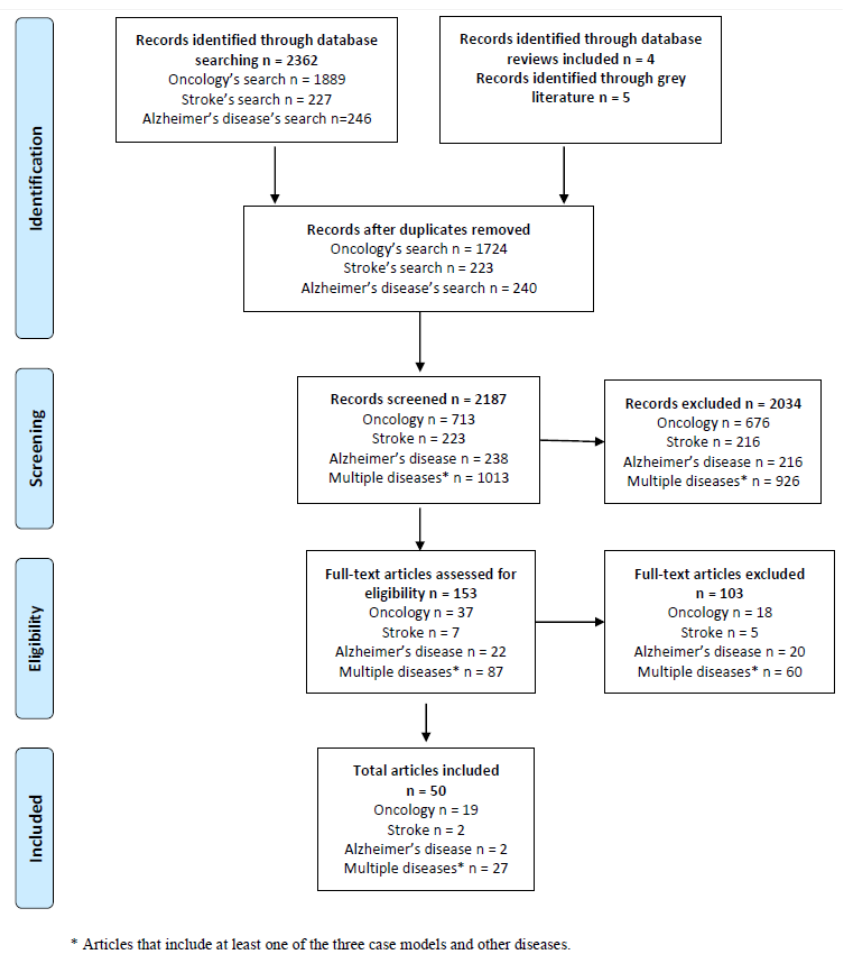
Figure 1. PRISMA flowchart describing process for article selection.